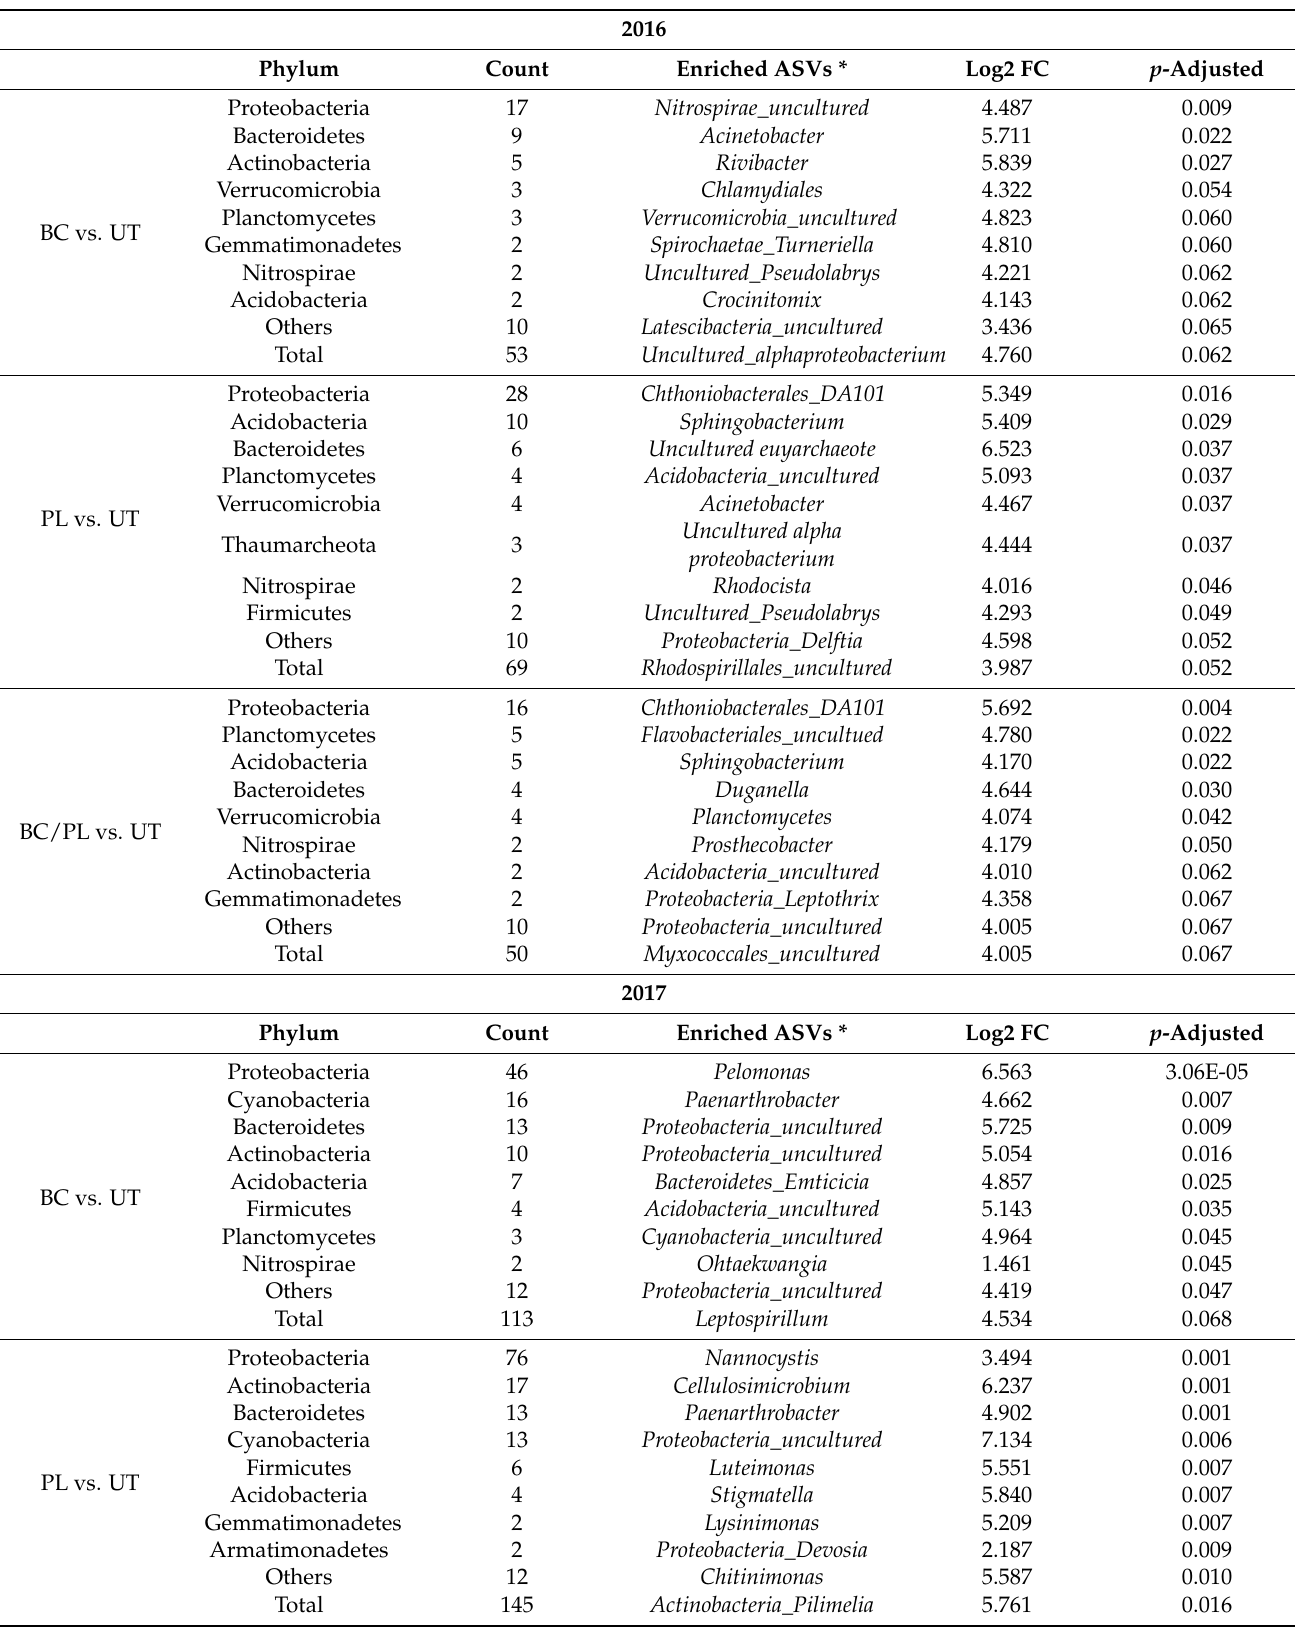
Table 9. The ASVs at the genus level enriched by different soil